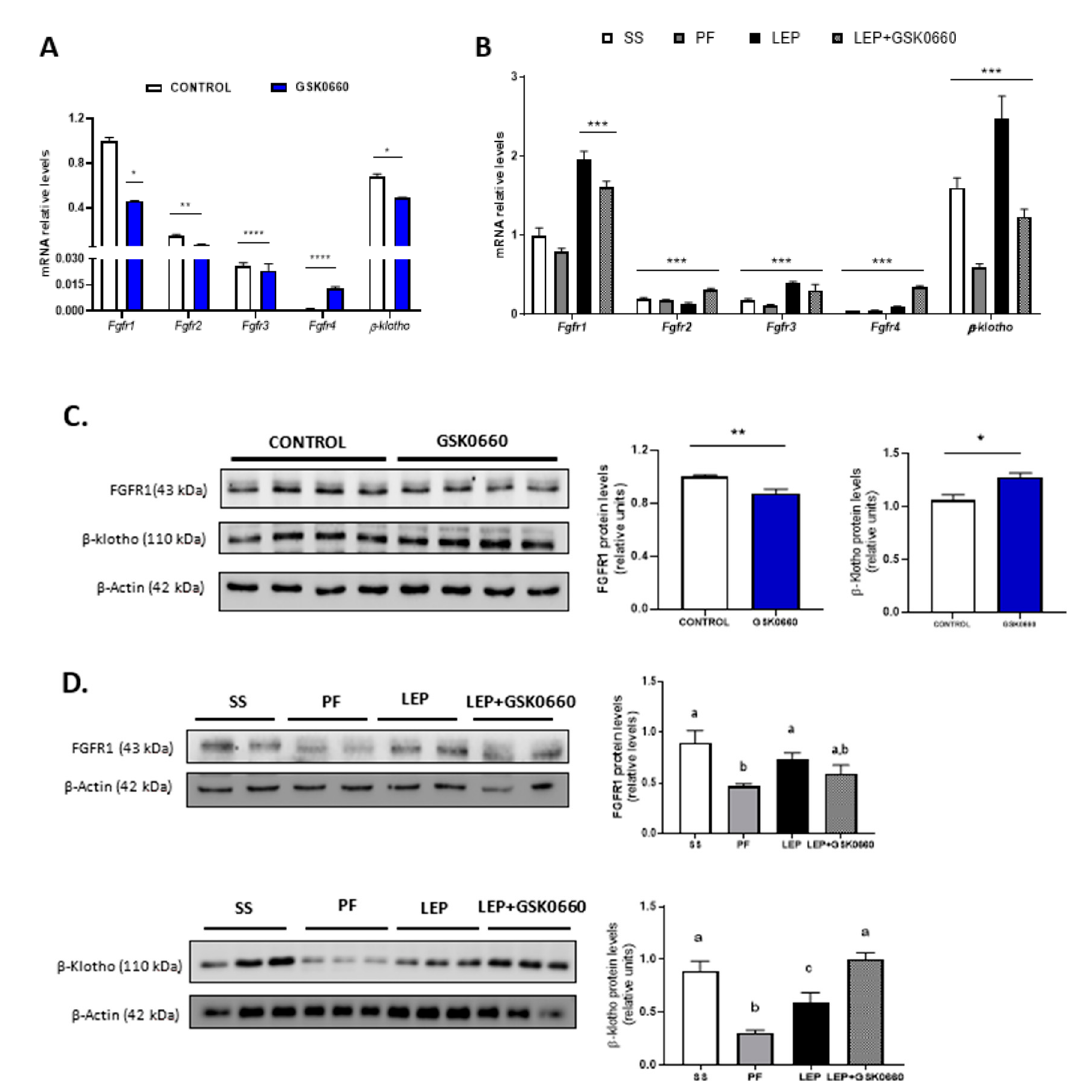
Figure 4. ( A ) Quantification and gene expression comparison between FGFR1-4 and β -klotho co-receptor in eWAT of rats after 7 days of vehicle (DMSO) control or intraperitoneal GSK0660 injection ( n = 6). ( B ) Gene expression comparison be- tween FGF receptors and β -klotho co-receptor in eWAT of rats after 7 days of chronic central treatment of vehicle (SS and PF), leptin, or leptin and ip GSK0660 co-administration ( n = 4–6). ( C ) Representative Western blot and relative